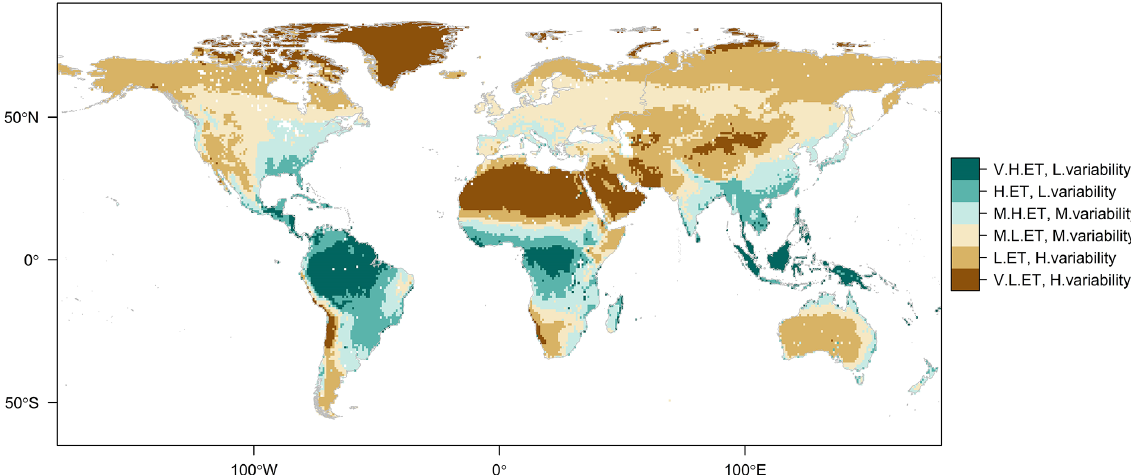
Figure 6. Classification of the land into six distinct dry and wet ET regimes using K -means unsupervised classification based on DOLCE V3 annual ET mean and within-year relative variability both computed for 1980–2018. The six ET regimes are labelled from driest to wettest as very low ET with high variability (V.L.ET, H.variability), (ii) low ET with high variability (L.ET, H.variability), (iii) mild low ET with medium variability (M.L.ET, M.variability), (iv) mild high ET with medium variability (M.H.ET, M.variability), (v) high ET with low variability (H.ET, L.variability) and (vi) very high ET with low variability (V.H.ET,